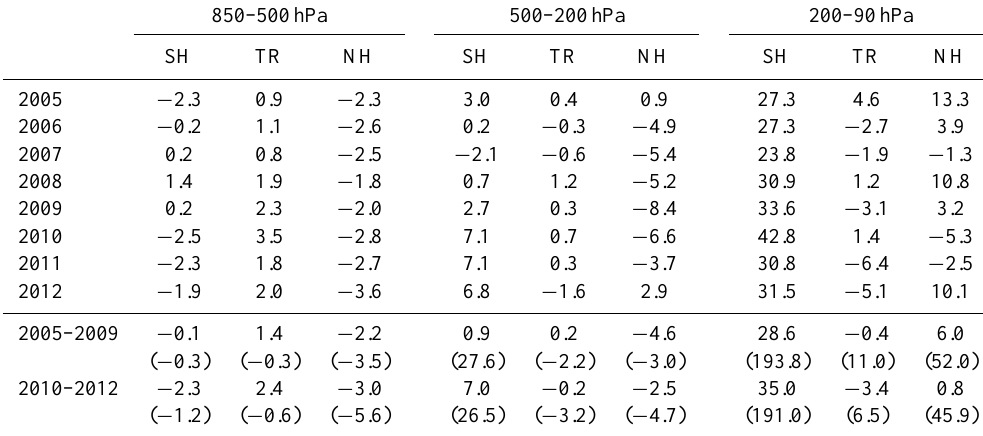
Table 3. Comparisons of the mean O 3 concentrations between the reanalysis run and the WOUDC ozonesonde observations in the